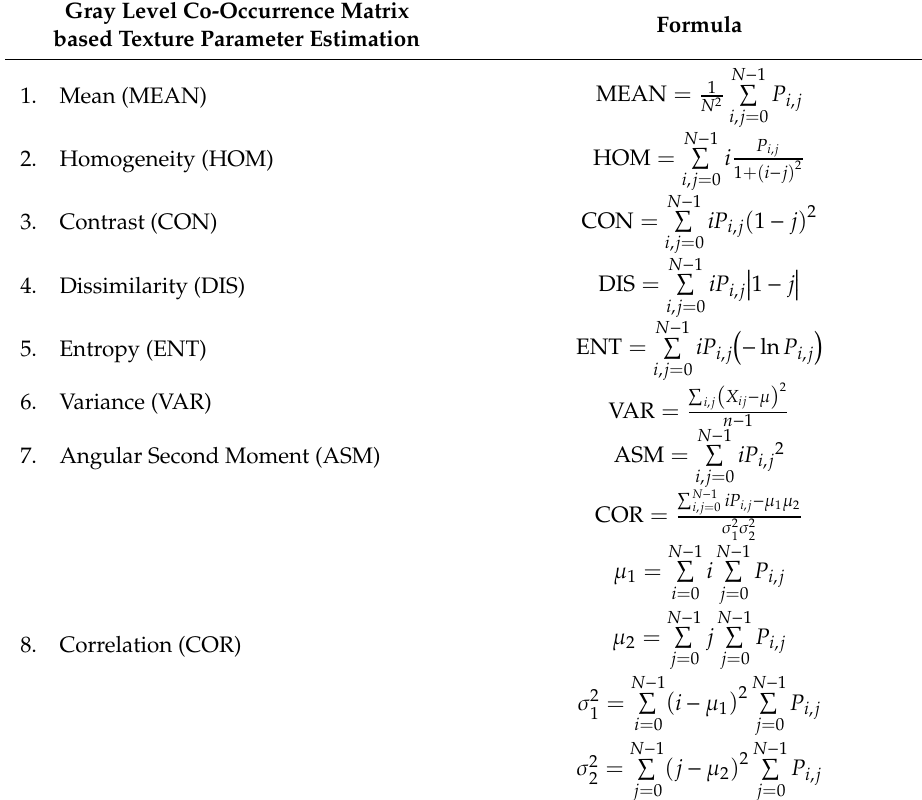
Table 3. Formula of textural variables used in this